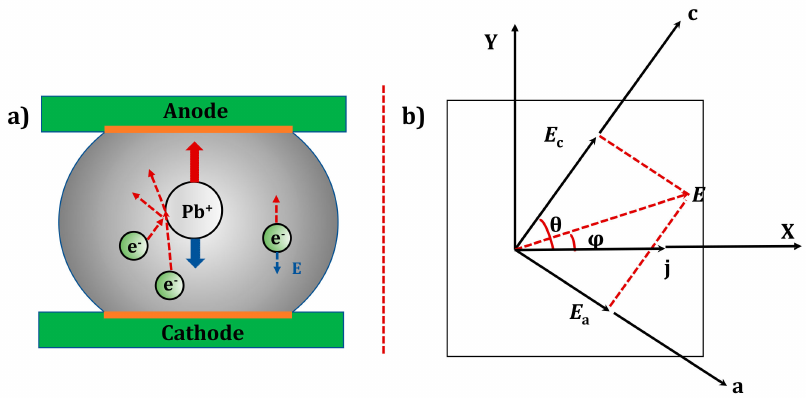
Figure 4. Schematic maps of the dynamics and migration direction in electromigration. ( a ) Diagram of momentum exchange in electromigration; and ( b ) cross section of a α -Sn